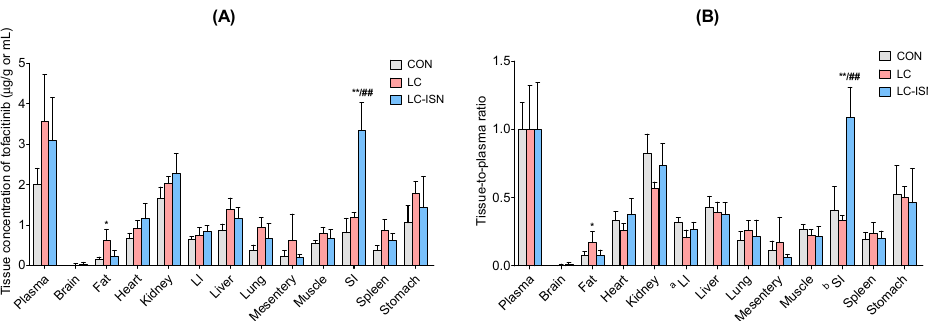
Figure 4. ( A ) Tissue concentration ( µ g/mL for plasma or µ g/g for tissue) and ( B ) tissue-to-plasma (T/P) ratio of tofacitinib at a dose of 10 mg/kg at 30 min after 1 min intravenous infusion to CON, LC and LC-ISN rats ( n = 3, per group). Bars represent standard deviations. CON, control; LC, liver cirrhosis induced by N -dimethylnitrosamine; LC-ISN, LC with treatment of isosakuranetin; LI, large intestine; SI, small intestine. * p < 0.05 and ** p < 0.01 mean significantly different from CON rats, and ## p < 0.01 means significantly different between LC and LC-ISN rats.